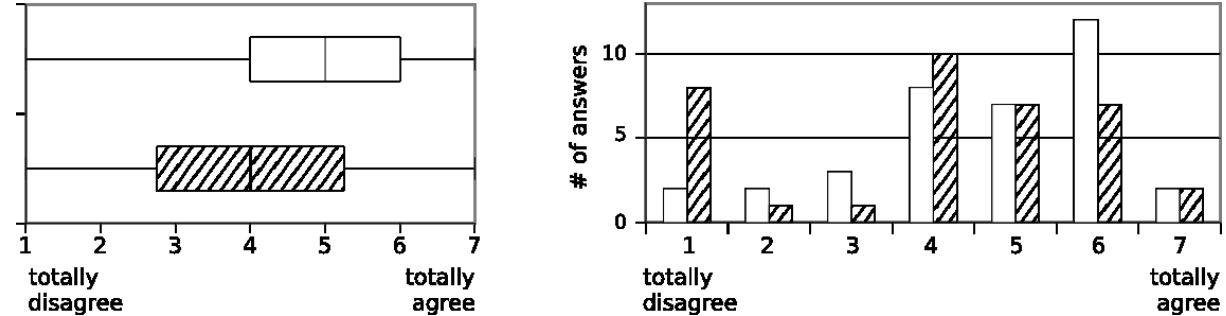
Figure 4. Details regarding usefulness. White bars: a translation system like xprompt is very helpful for communication with non-German speaking patients. Cross-hatched bars: with xprompt, I was able to provide assistance with language